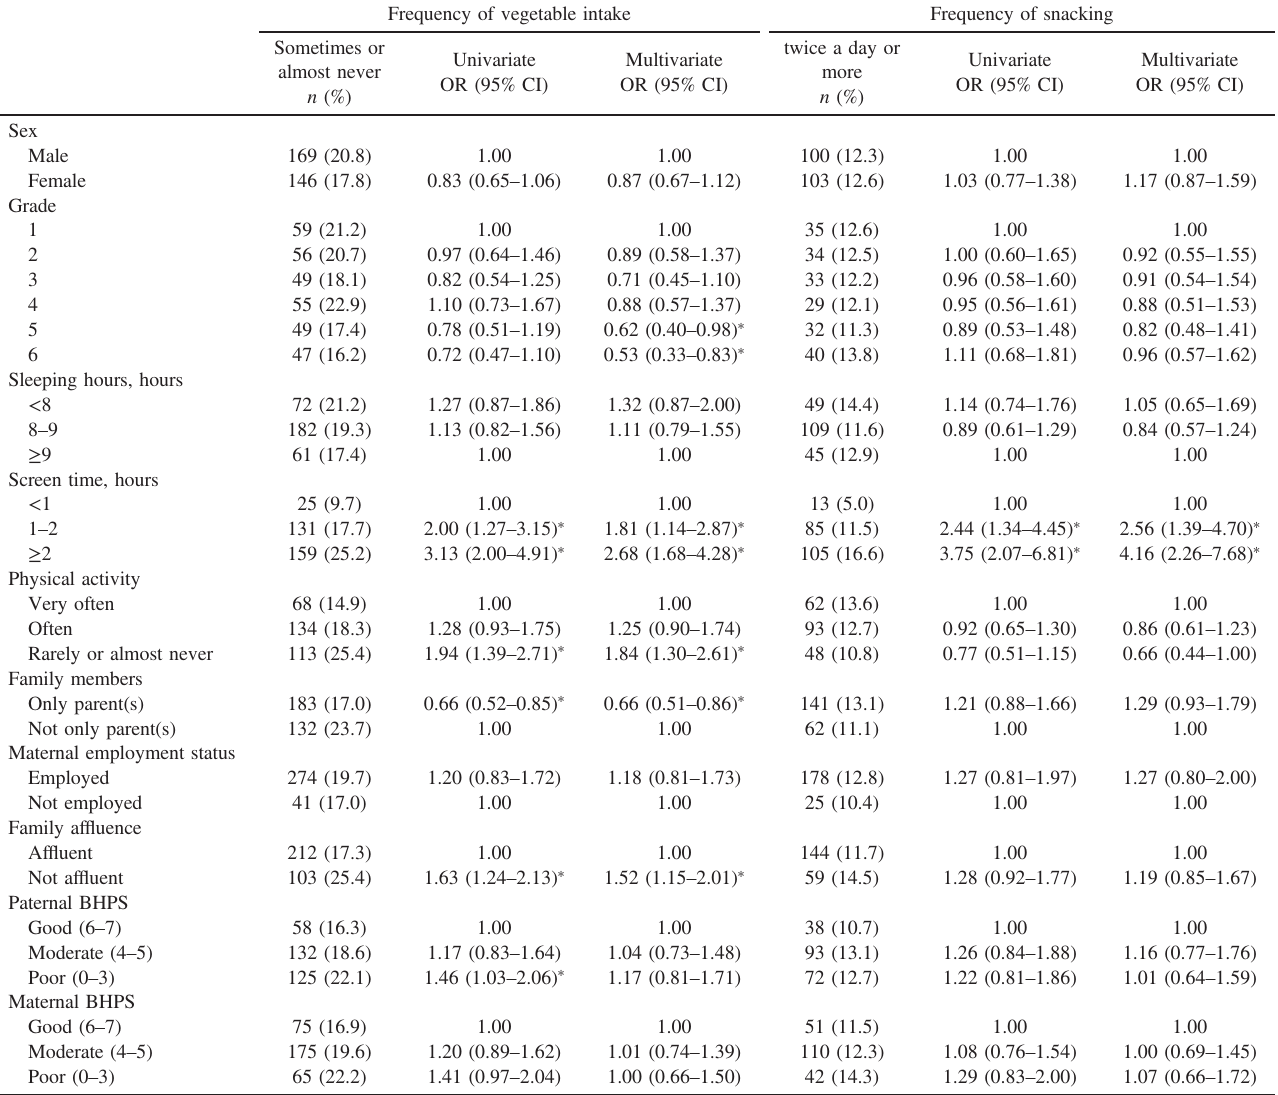
Table 4. The relationship between parental lifestyle factors and the frequency of vegetable intake or snacking of children Frequency of vegetable intake Frequency of